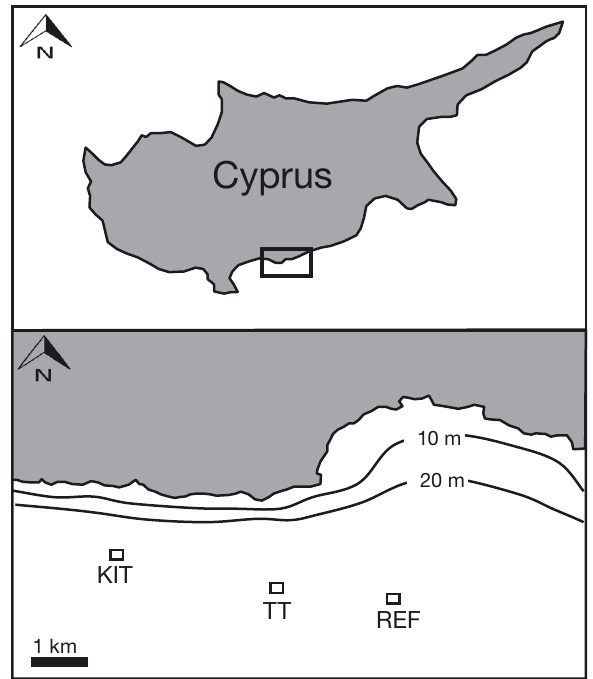
Fig. 1. Study area in Limassol Bay (south coast of Cyprus, East- ern Mediterranean). Sampling stations were located at 2 tuna fattening farms, codenamed TT (34°41’27”N, 33°15’54”E), KIT (34°41’41”N, 33°14’06”E) and at a reference station (REF), 2 km from the nearest farm (34°41’32”N,